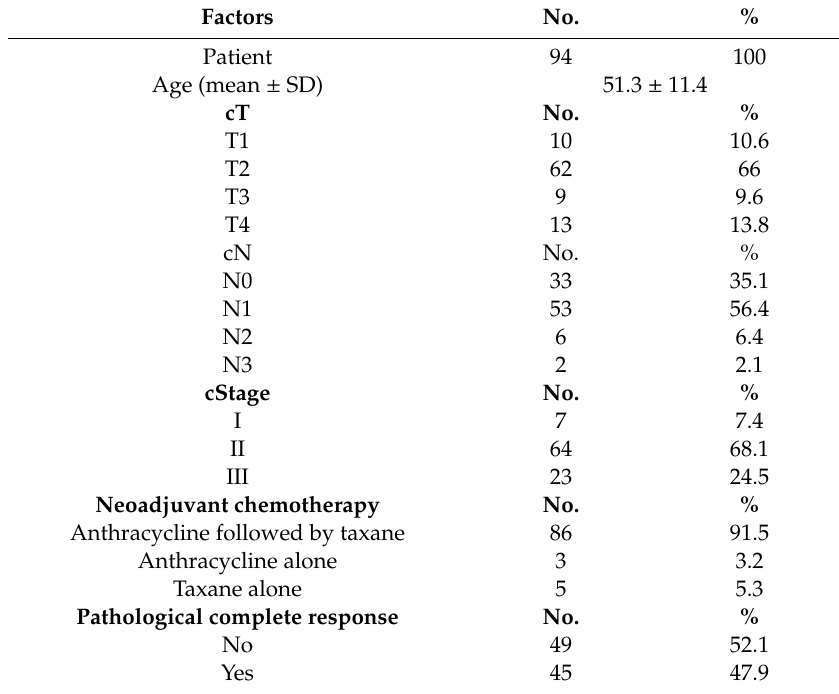
Table 1. Clinicopathologic characteristics of the 94